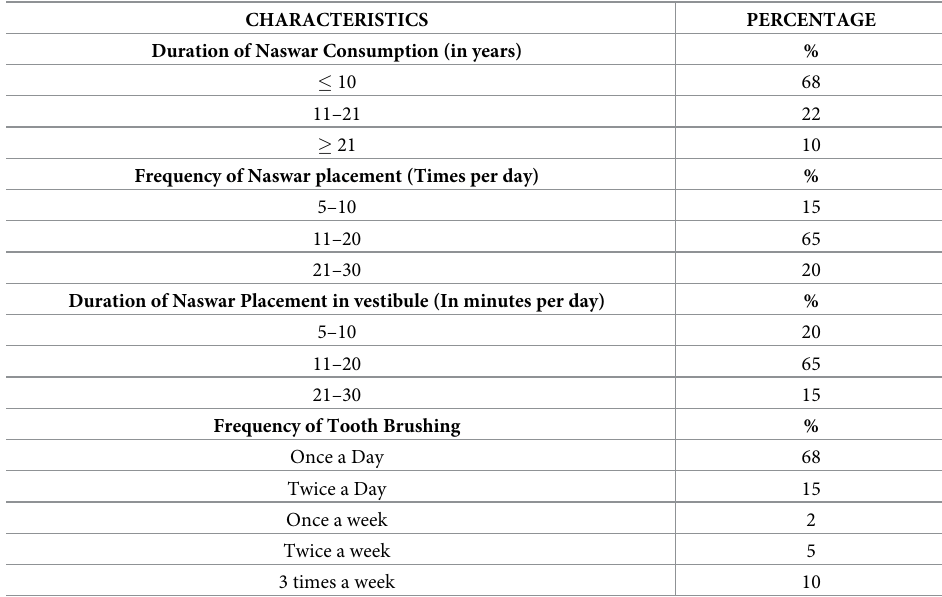
Table 2. Characteristics of naswar users.